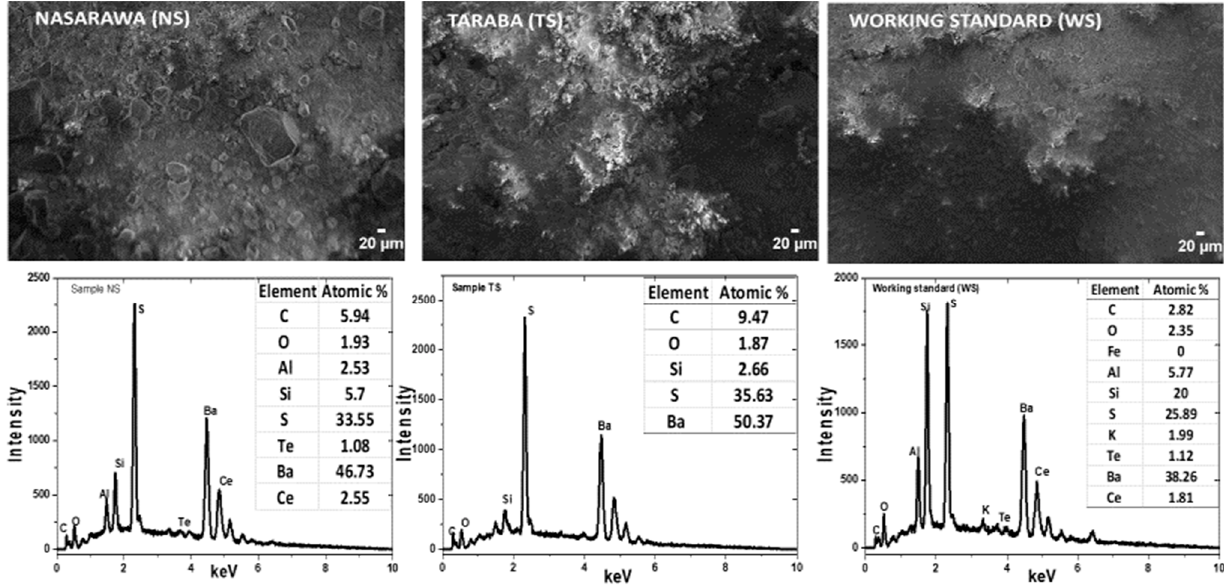
Figure 2. SEM-EDX morphology and sample element atomic percentages. Table 1. Energy-dispersive X-ray spectroscopy (EDS) atomic percentage of elements from barite mineral samples from different mining sites.